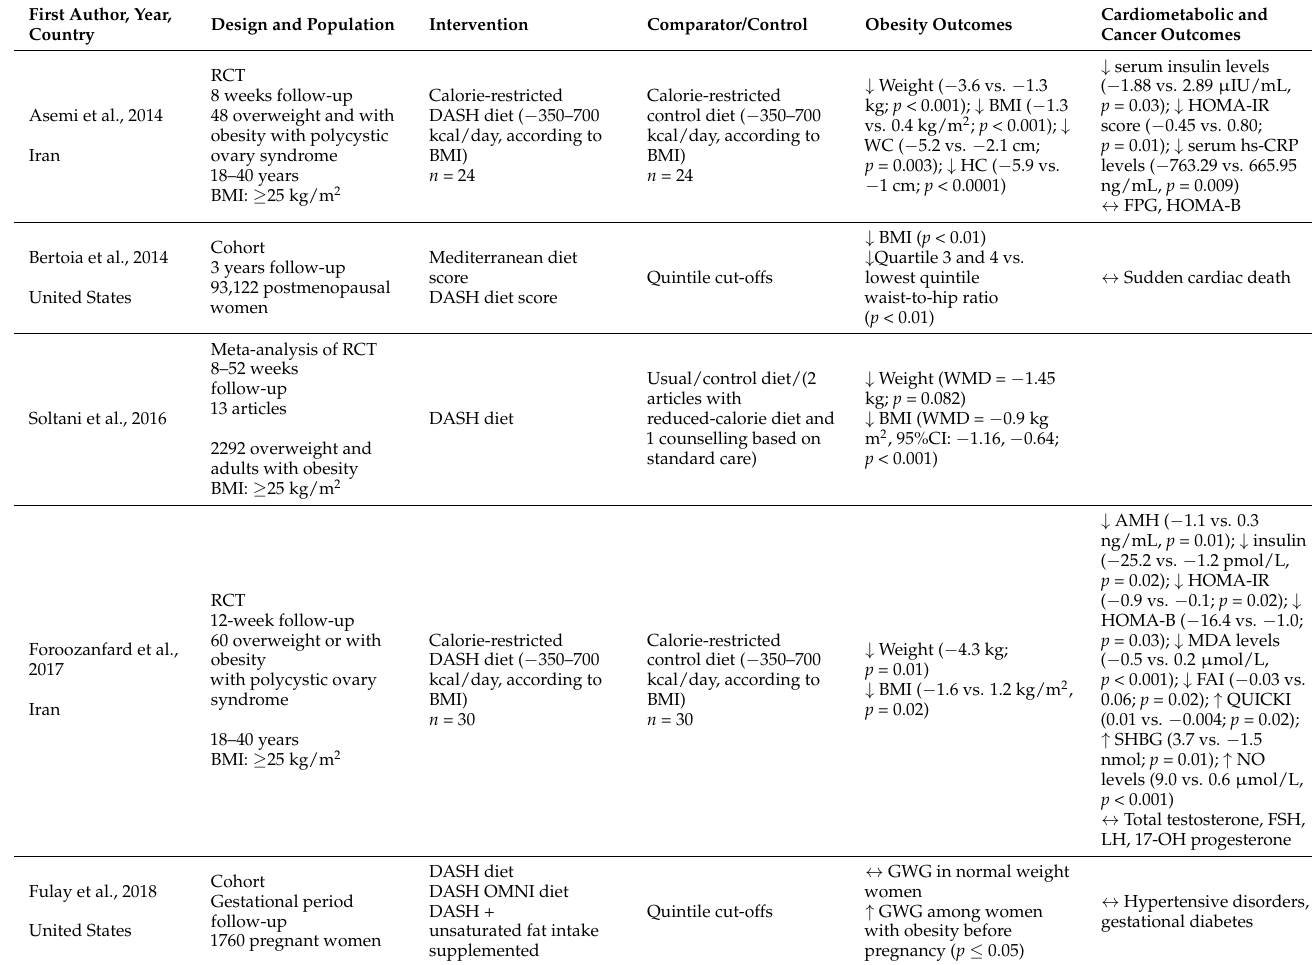
Table 3. Summary of studies with DASH diets for weight loss, obesity, cardiometabolic and cancer